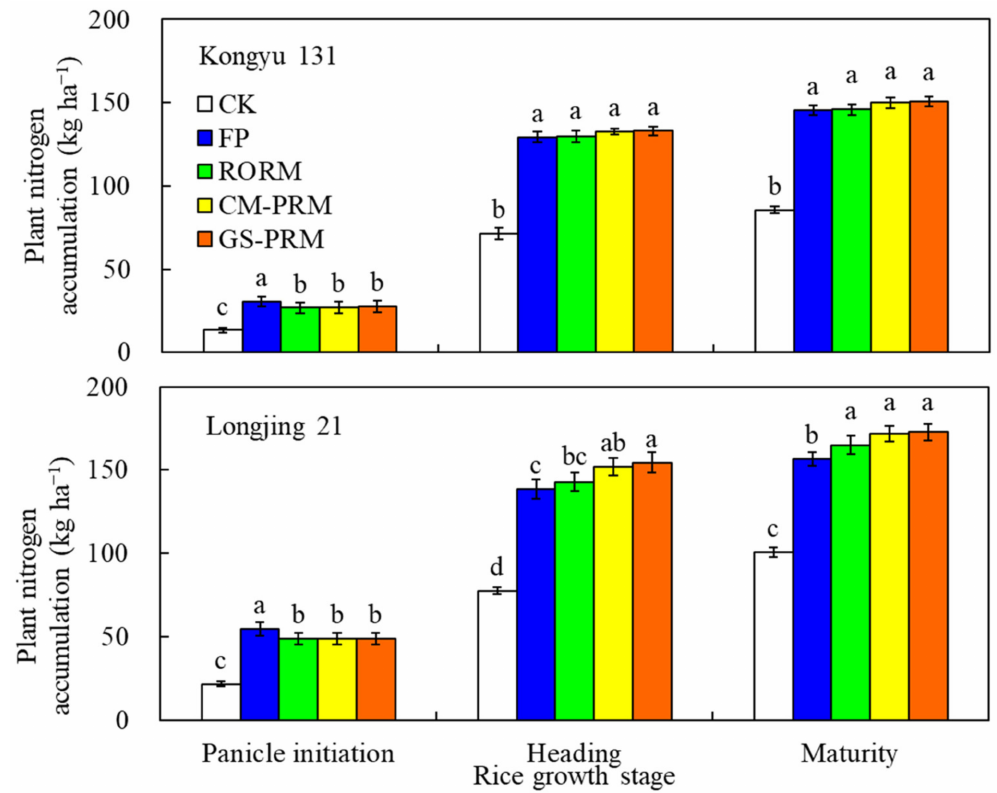
Figure 4. The three-year (2011–2013) average of plant nitrogen accumulation of two rice varieties, Kongyu 131 ( top ) and Longjing 21 ( bottom ), at different growth stages produced in different rice man- agement systems. CK, FP, RORM, CM_PRM, and GS_PRM represent check, farmer’s practice, regional optimum rice management, chlorophyll meter-based precision rice management, and GreenSeeker sensor-based precision rice management, respectively. Different letters indicate significant differences at p < 0.05 level at the same growth stage. The error bars indicate the standard